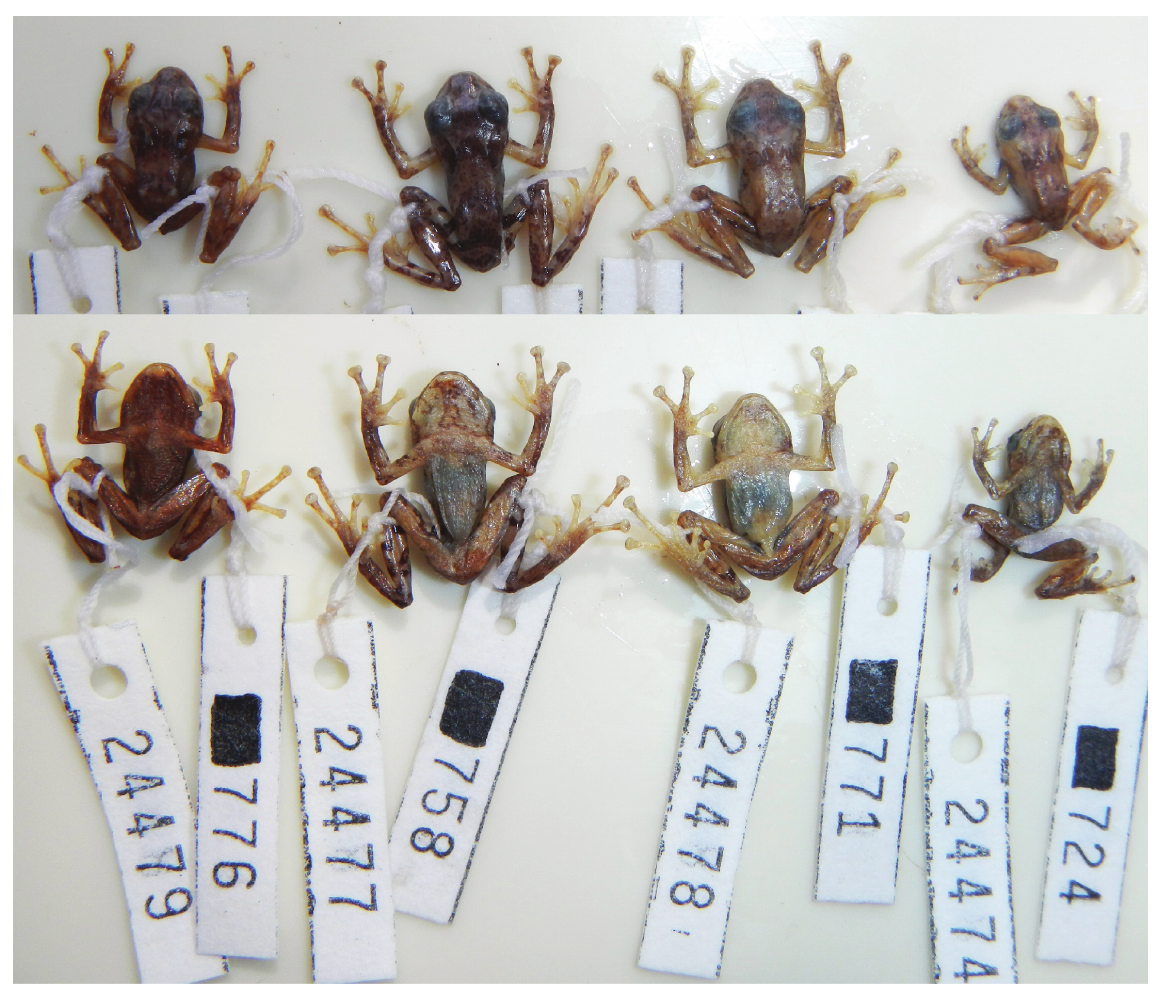
Fig. 6. Paratypes of Pristimantis boucephalus sp. nov. in dorsal (upper row) and ventral (lower row) views. From left to right: ♀ (MUSM 24479), ♂ (MUSM 24477), ♂ (MUSM 24478), juvenile (MUSM 24474). Photos by E.